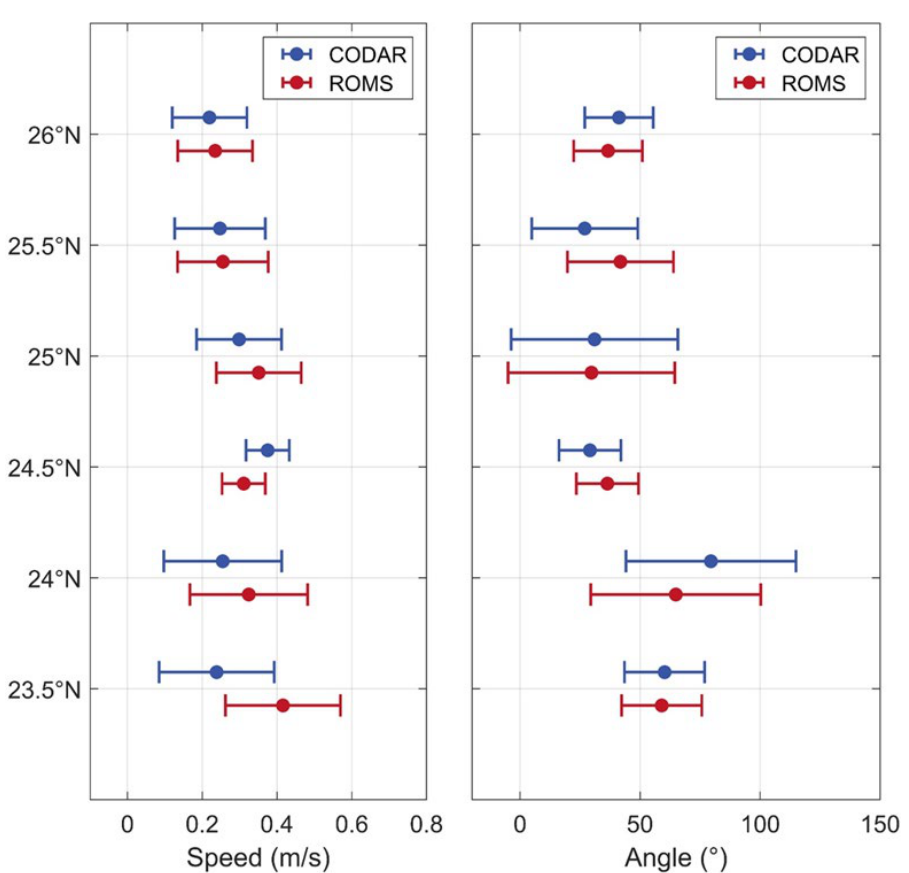
Figure 8. Comparisons of average flow fields between ROMS and CODAR data. The dots represent the mean and the bars represent the standard deviation of each latitude band.